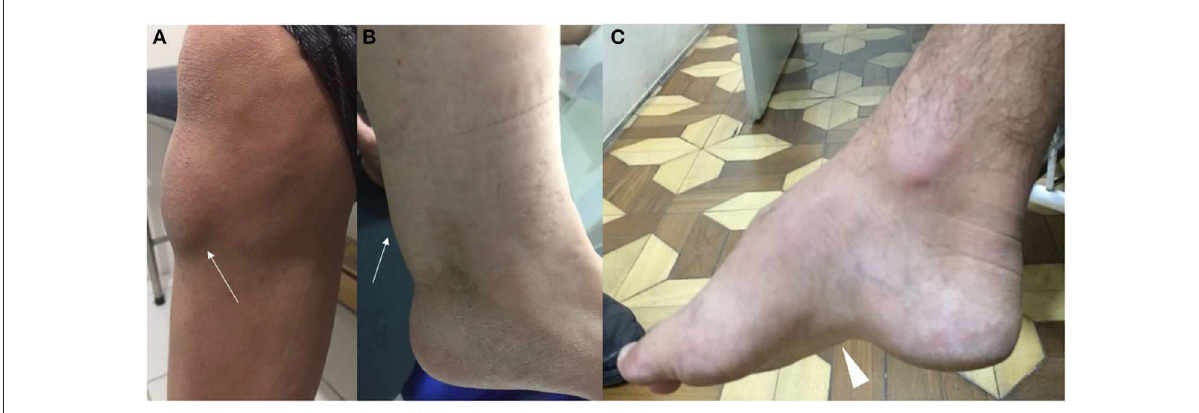
FIGURE3 Clinical examination findings in CTX. Note the presence of tendon xanthoma (white arrows) located in the anterior tibial tuberosity (A) and the Achilles tendon (B) . Pes cavus (white arrowhead) is also another possible feature (C)